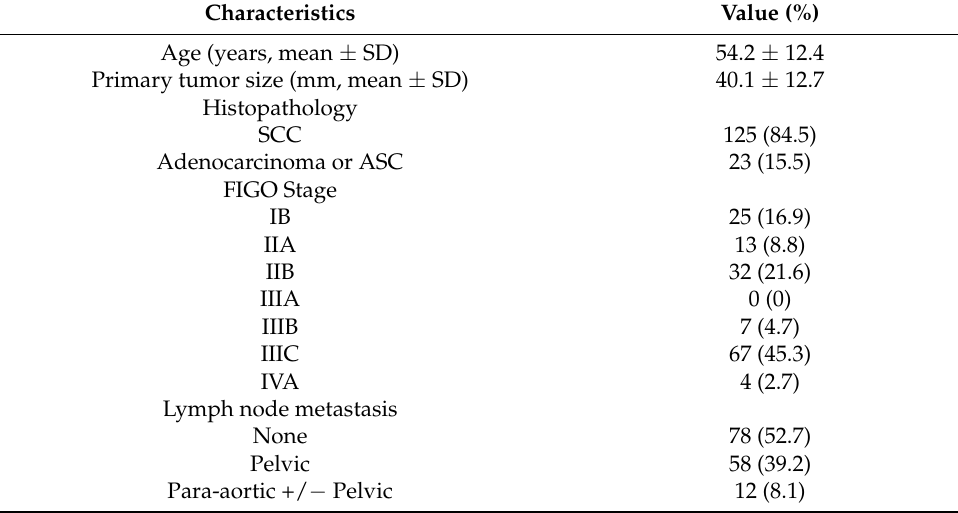
Table 1. Characteristics of patients and